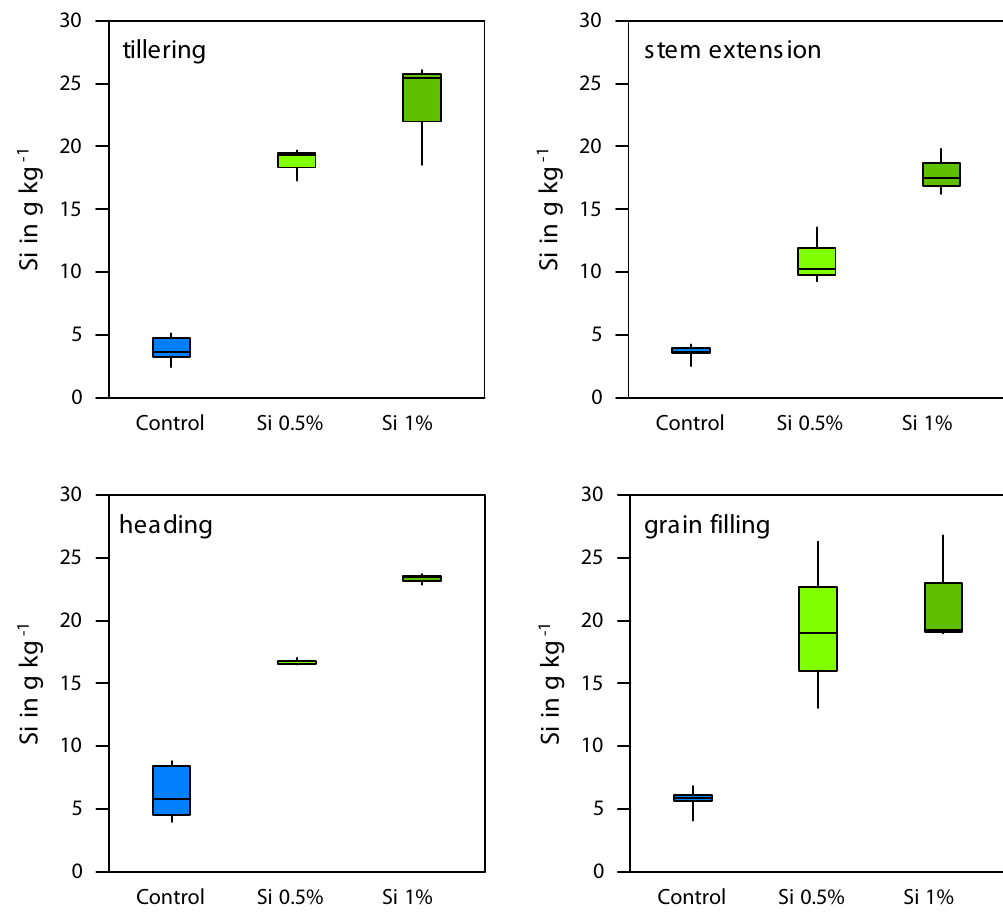
Figure 7. Leaf silicon concentration for the different treatments over the growing